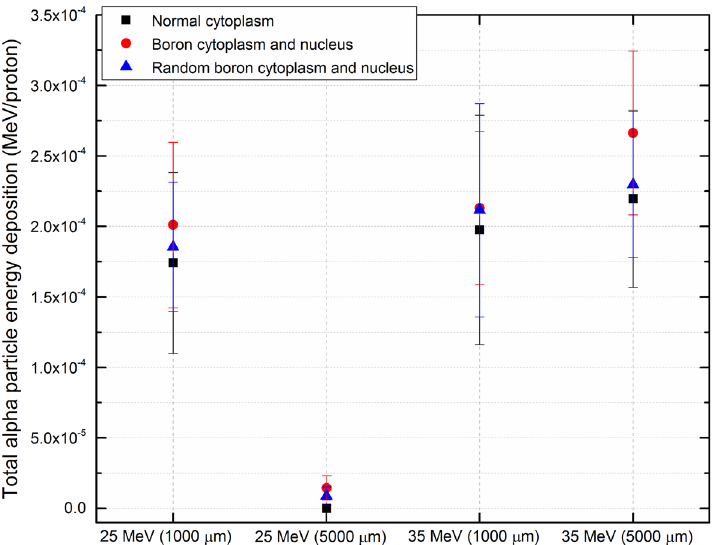
Figure 10. The total alpha particle energy deposition for different incident proton energies and for different buffer medium thicknesses, for boron and random boron filled cytoplasm and nucleus.